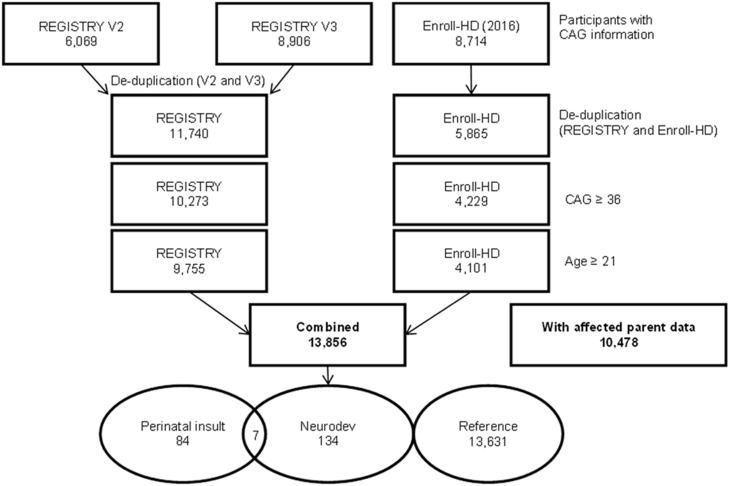
Flowchart of included participants and exclusions. Neurodev, neurodevelopmental disorders.